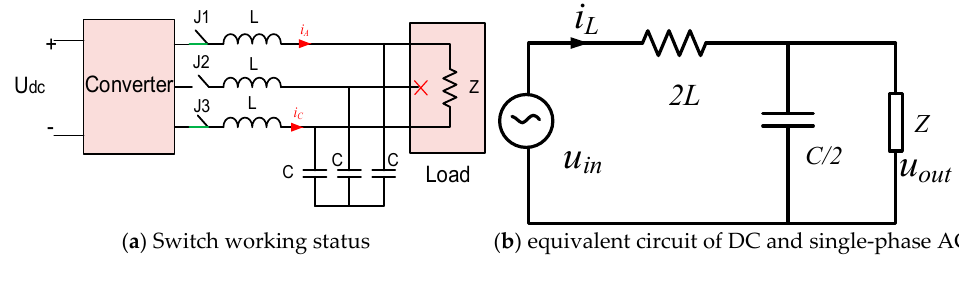
Figure 2. The structure of DC is charging mode and single-phase AC charging mode.